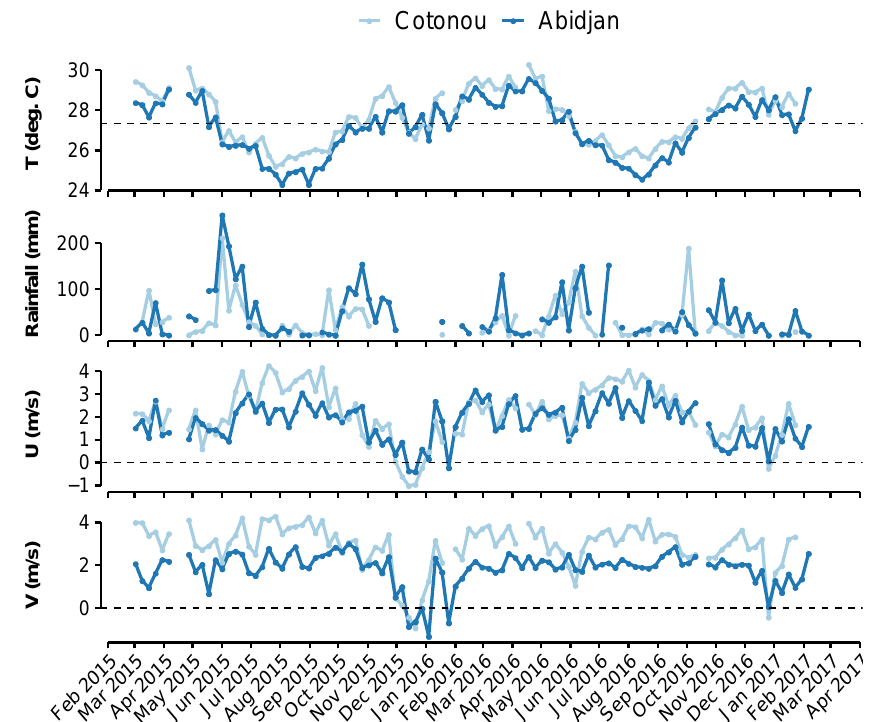
Figure 2. Weekly mean temperature, cumulative rainfall, mean zonal U (U > 0 indicates wind from the West) and meridional V (V > 0 indicates wind from the South) winds recorded in Abidjan (Felix Houphouet Boigny airport) and Cotonou (Cadjehoun airport) from February 2015 to March 2017. The traffic site in Cotonou (CT) is located in the Dantokpa area, one the biggest markets in Africa. The transport sector in Cotonou is dominated by two-wheel vehicles with gasoline as the main fuel source. The sampler instrument is located on a 4 m high balcony, above a major cross-road (Figure 1). The traffic site in Abidjan (AT) is located in the Adjamé sector. The traffic in Abidjan is dominated by cars and small buses using diesel fuel. The sampler being located on the roof of a commercial building. The domestic fireplace site (AF) is located in the market courtyard of Yopougon-Lubafrique. There is heavy use of fireplaces to smoke meat and fish or roast peanuts, and the main fuel source is hevea wood, in a total of 25 fireplaces (Figure 1). The instrumentation in this case is located on a 3-meter height tower. The waste burning site (AL) is located near the public landfill of Abidjan, in the village of Akeoudo. The landfill of Abidjan was closed in 2019 and until then was collecting all the waste produced in the district of Abidjan for the last 50 years. The dump has received about 1M t of waste a year in the last years [49].